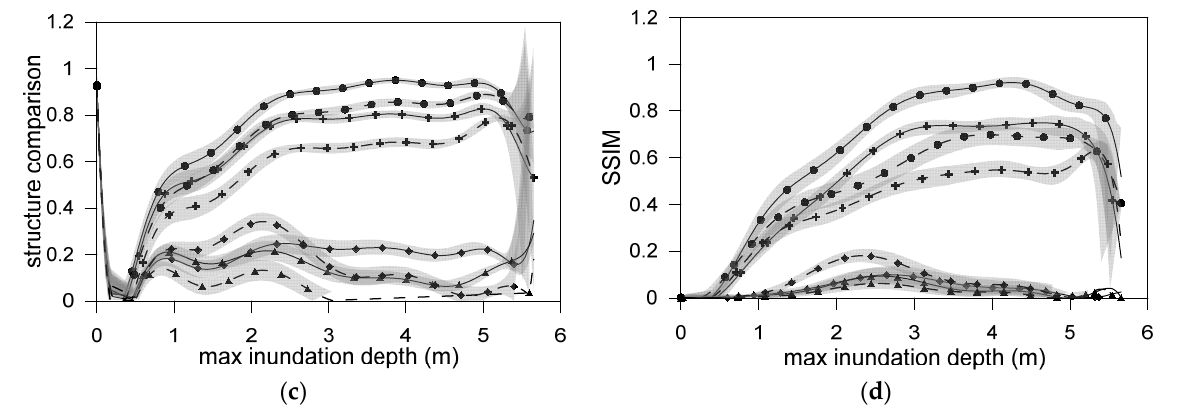
Figure 11. Structural similarity index (SSIM) similarity in the flood results produced by various models to the corresponding actual data: ( a ) luminance comparison, ( b ) contrast comparison, ( c ) structure comparison, and ( d ) SSIM comparison.